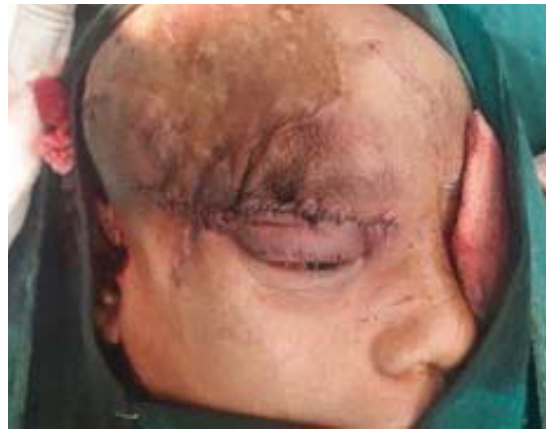
Figure 4. Postoperative picture showing curvilinear incision below the right eyebrow and acceptable cosmesis after excision of right scalp-orbital AVM.